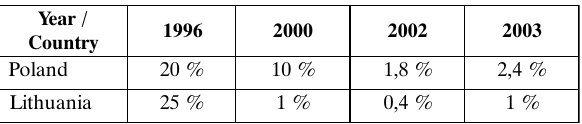
Table 2. Gross Domestic Product in Poland and Lithuania, in 1990–2003, selected years, in million of USD